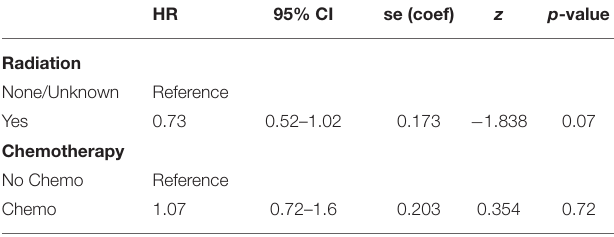
TABLE 3 | The results of multivariate SH model for metaplastic breast cancer (MBC).